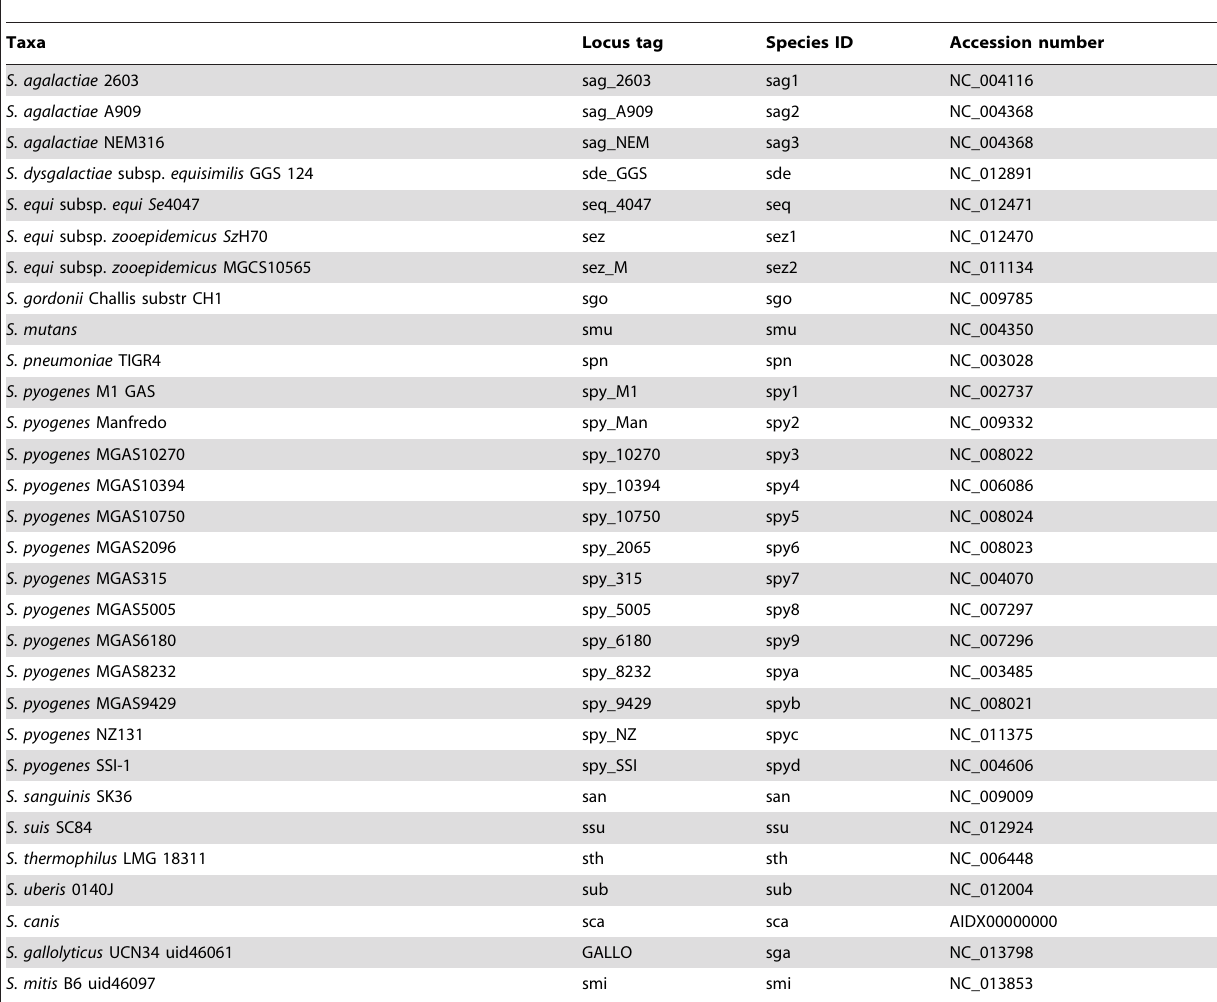
Table 1. Streptococcus genomes used in the